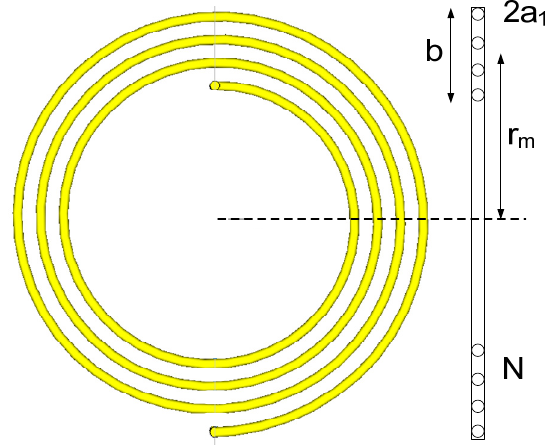
Figure 2. Dimension of multi-turn flat spiral for inductance